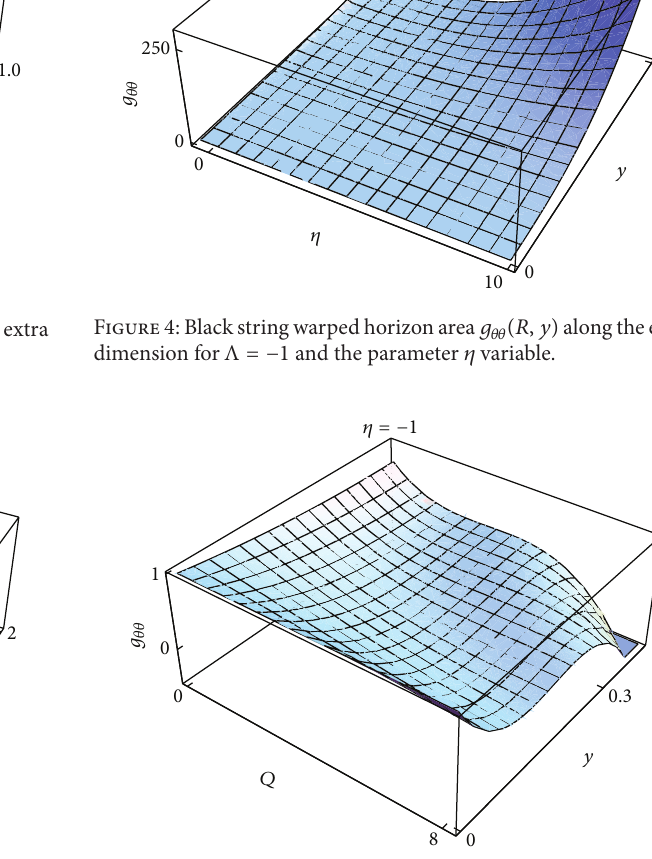
Figure 5: Black string warped horizon area 𝑔 𝜃𝜃 (𝑅,𝑦) along the extra dimension, as a function of the generalized dark radiation tidal charge parameter 𝑄 𝜂 , for 𝜂 = −1 .